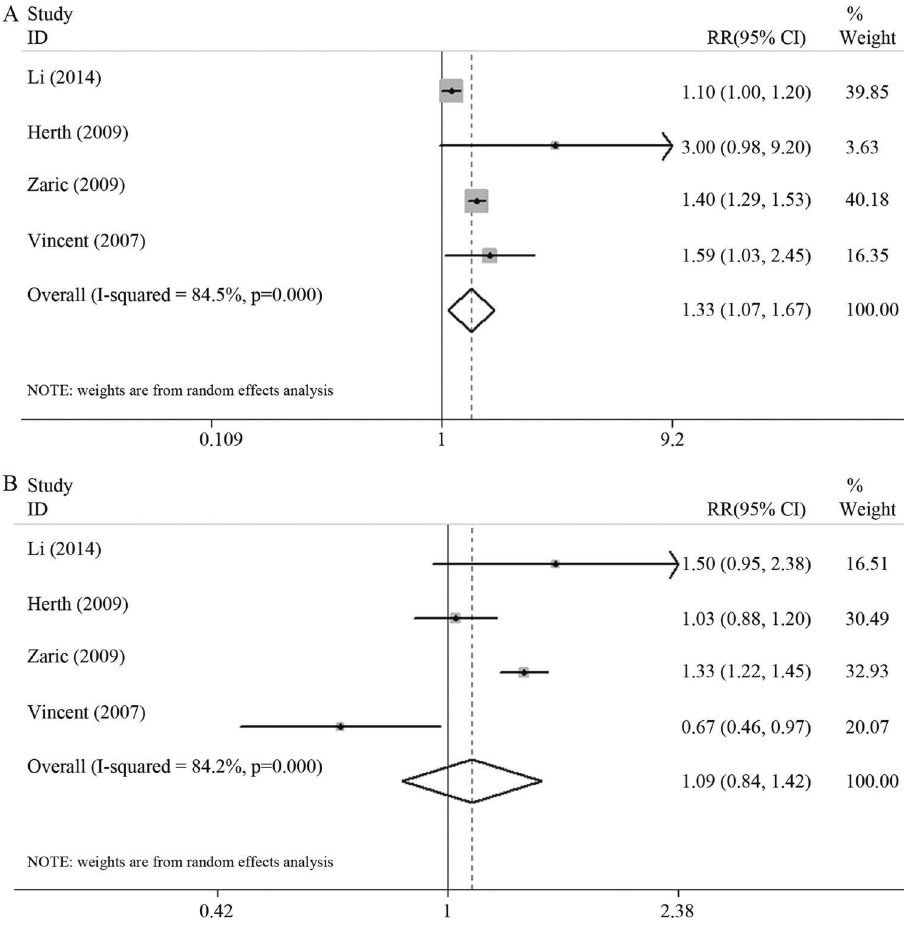
Figure 5 - A. The pooled RR for the sensitivity of NBI vs the sensitivity of WLB for the detection of early lung cancer and invasive lung cancer; B. The pooled RR for the specificity of NBI vs the specificity of WLB for the detection of early lung cancer and invasive lung cancer.